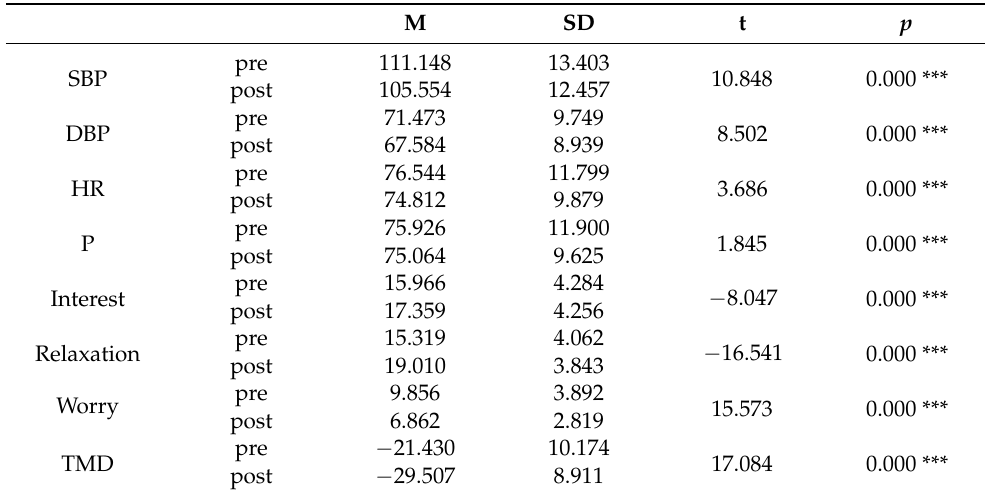
Table 5. Pairwise comparison of post-VR and